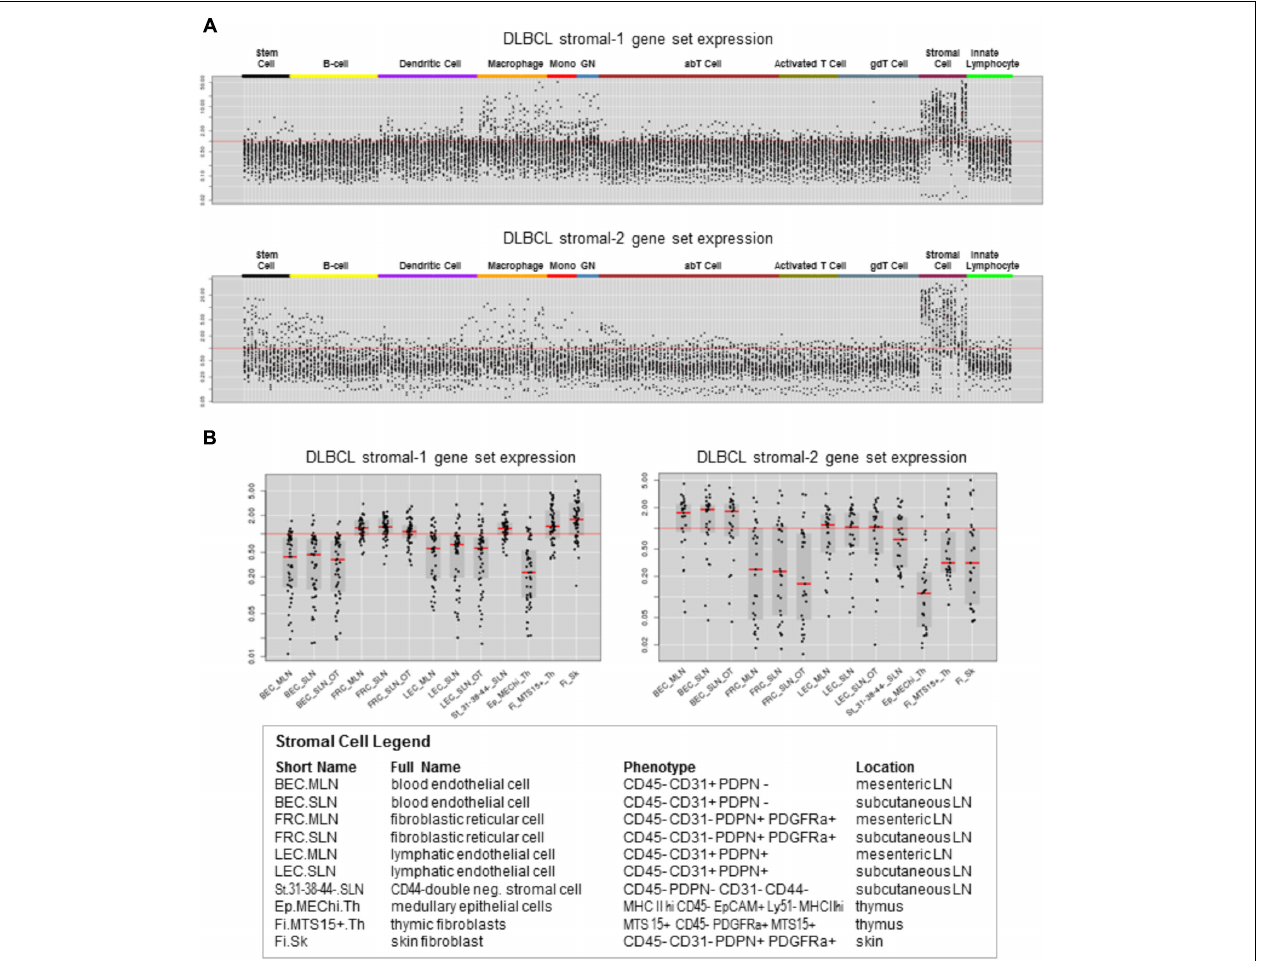
FIGURE 1 | DLBCL stromal-1 and stromal-2 signature genes are enriched in different stromal cell types. Expression of the DLBCL stromal-1 and stromal-2 signature genes in the Immunological Genome Project (ImmGen) data set. (A) Gene expression values normalized across 249 mouse immunological cell types. (B) Detailed view of gene expression values normalized to the stromal cell types shown in the legend. The graphs were generated using data from ImmGen